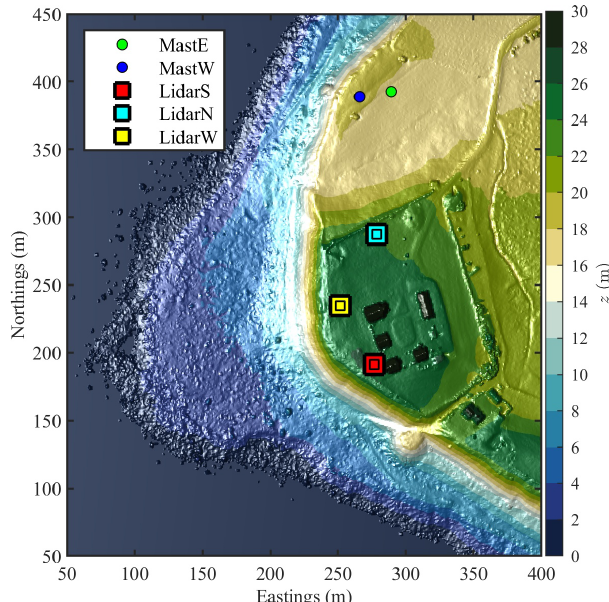
Figure 2. Local topography at the measurement site, obtained from a digital surface model generated using airborne laser instruments with a horizontal resolution of